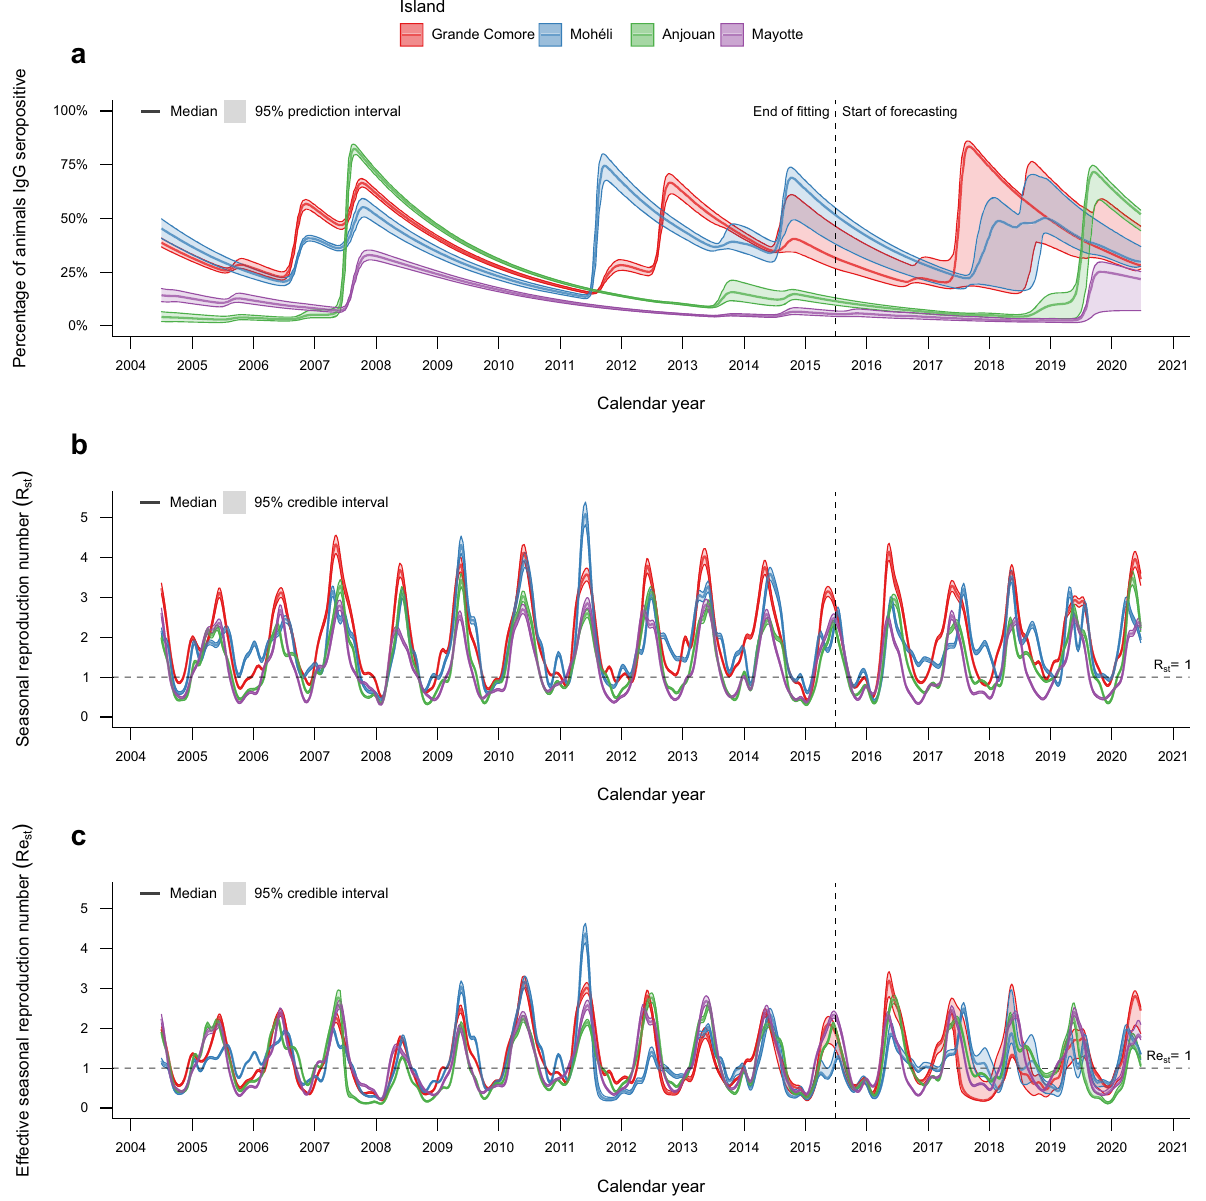
Fig. 4 Simulated RVF IgG seroprevalence on each island in the Comoros archipelago, 2004 – 2020, for the best fi tted model (Model 3b). The metapopulation model was fi tted to age-strati fi ed sero-surveys from July 2004 until June 2015 for Grande Comore (red), Mohéli (blue), Anjouan (green) and Mayotte (purple). Fitted models were then simulated until July 2020. a Median (solid line) and 95% prediction interval (coloured bands) of IgG seroprevalence. b Median (solid line) and 95% credible interval (coloured bands) of the seasonal reproduction number ( R st ). c Median (solid line) and 95% credible interval (coloured bands) of the effective seasonal reproduction number ( Re st ). Distributions shown were estimated from 1000 realisations of the metapopulation